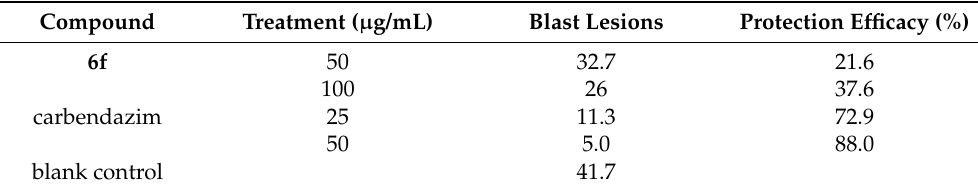
Figure 5. Protective activity of 6f against rice blast (RB). Table 4. Protective activity of 6f against RB a .